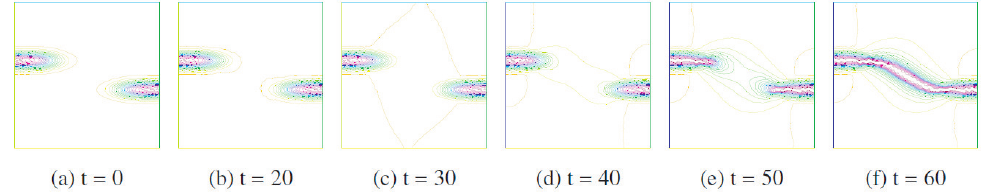
Figure A1. Time evolution of the phase-field variable z ( x , t ) (Case